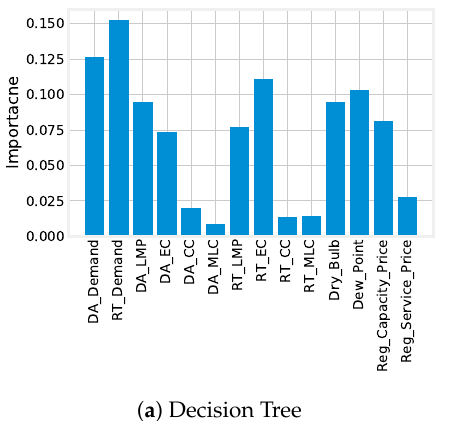
Figure 9. Feature